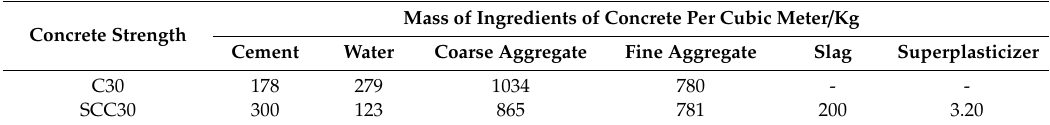
Table 1. Mix proportion of concrete.